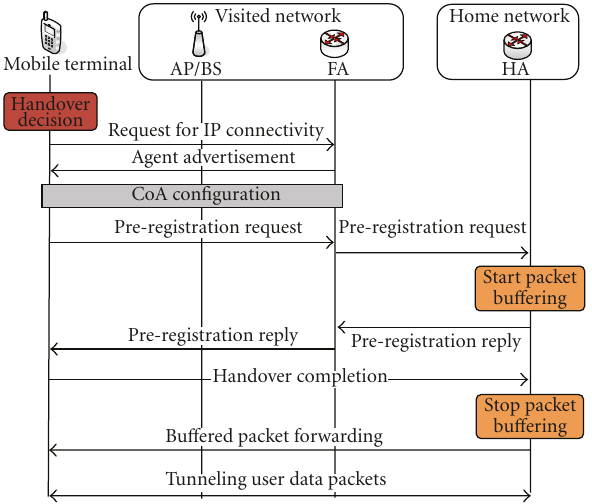
Figure 5: Generic MIP signaling for handover execution procedure.